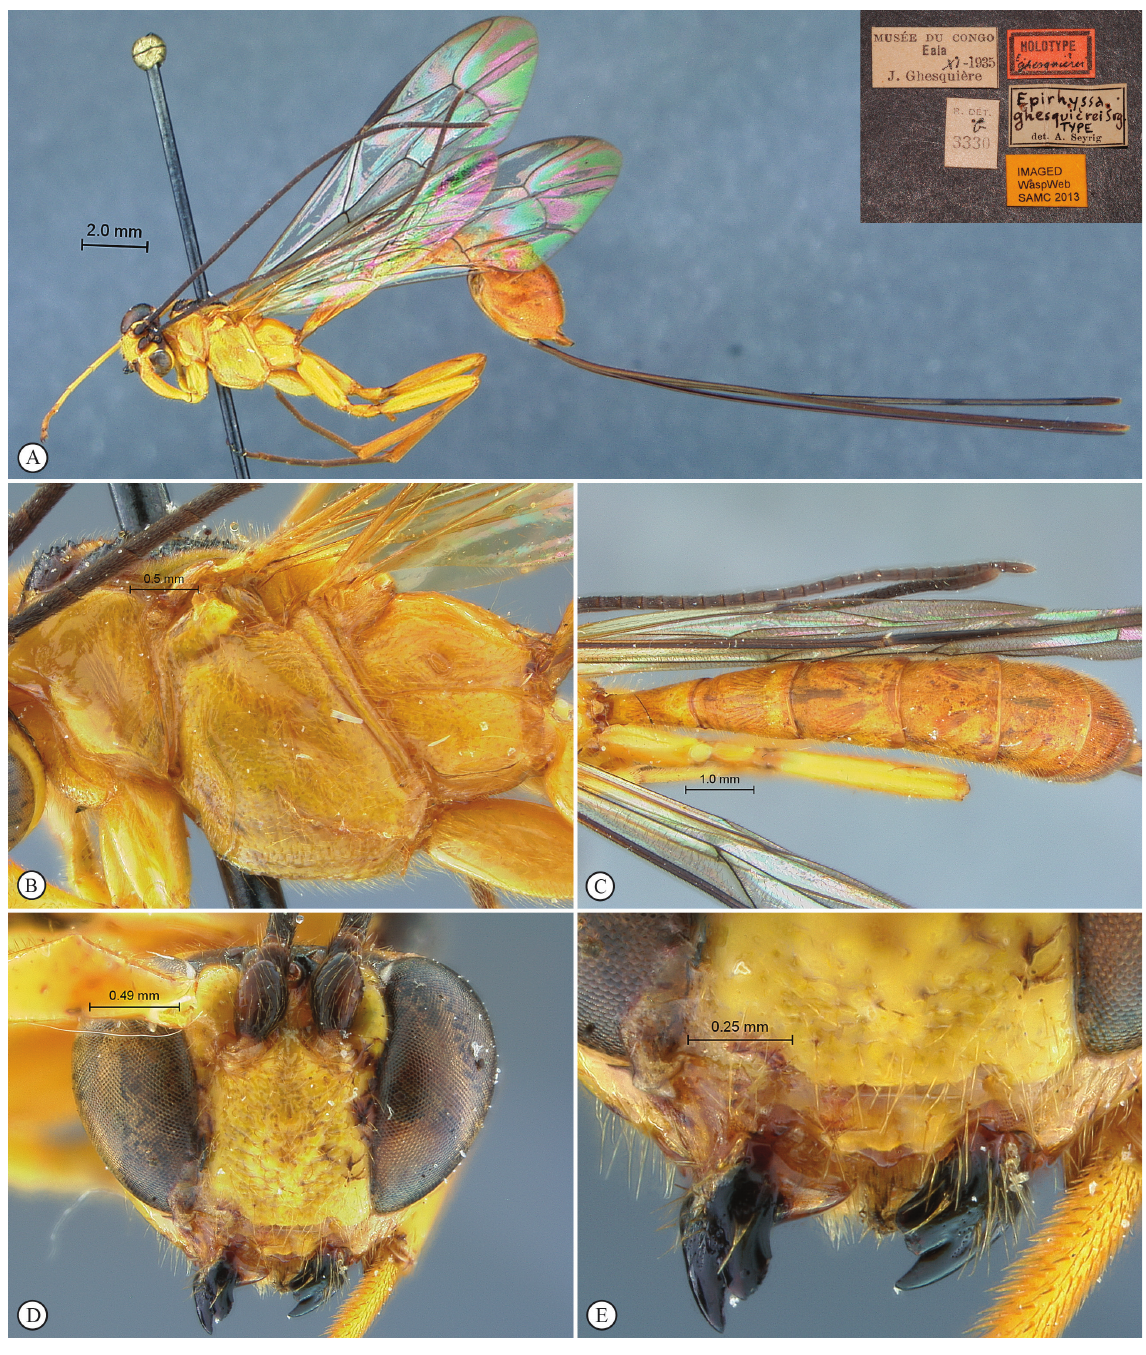
Fig. 3. Epirhyssa ghesquierei Seyrig, 1937, holotype, ♀. A . Habitus, lateral view (inset: data labels). B . Mesosoma, lateral view. C . Metasoma, dorsal view. D . Head, anterior view. E . Mandibles, anterior